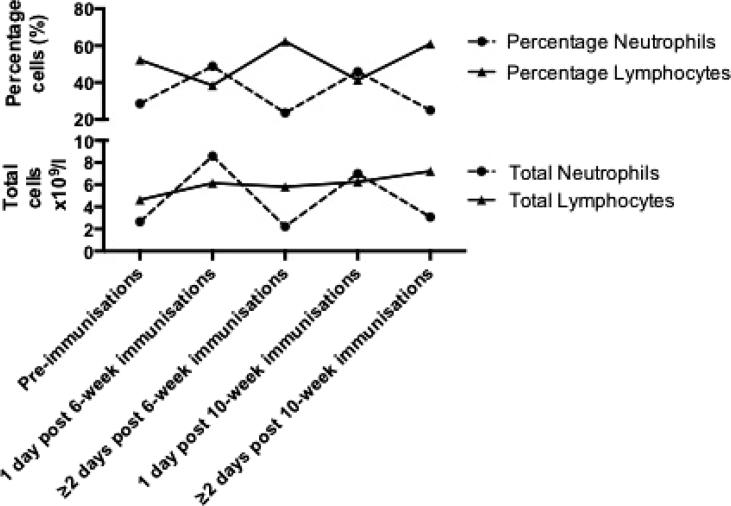
Total and percentage neutrophils and leucocytes by immunization status.